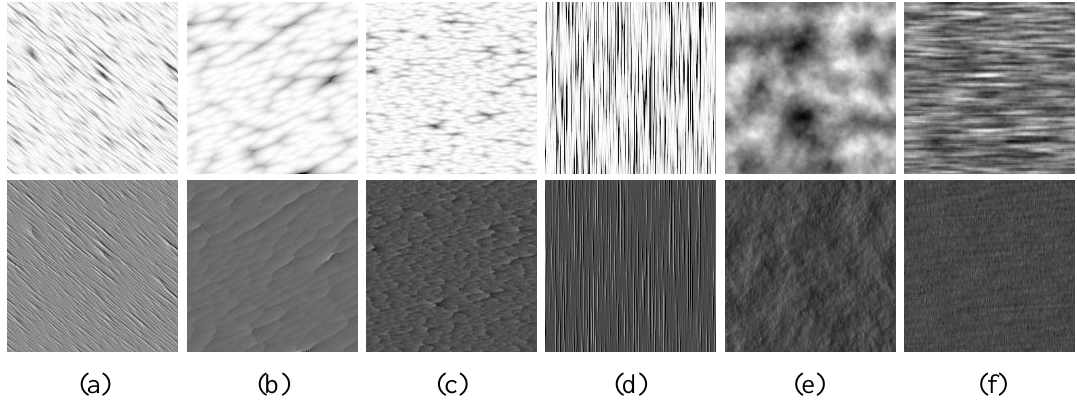
Figure 5. Textures generated using ellipsoids with different rotation angles and different combination rules: ( a , b ) are samples generated by using ellipsoids with different rotation angles; ( c , d ) are generated by a max rule; and ( e , f ) are generated by an addition rule. The samples in the first row are height maps and the samples in second row are relighting